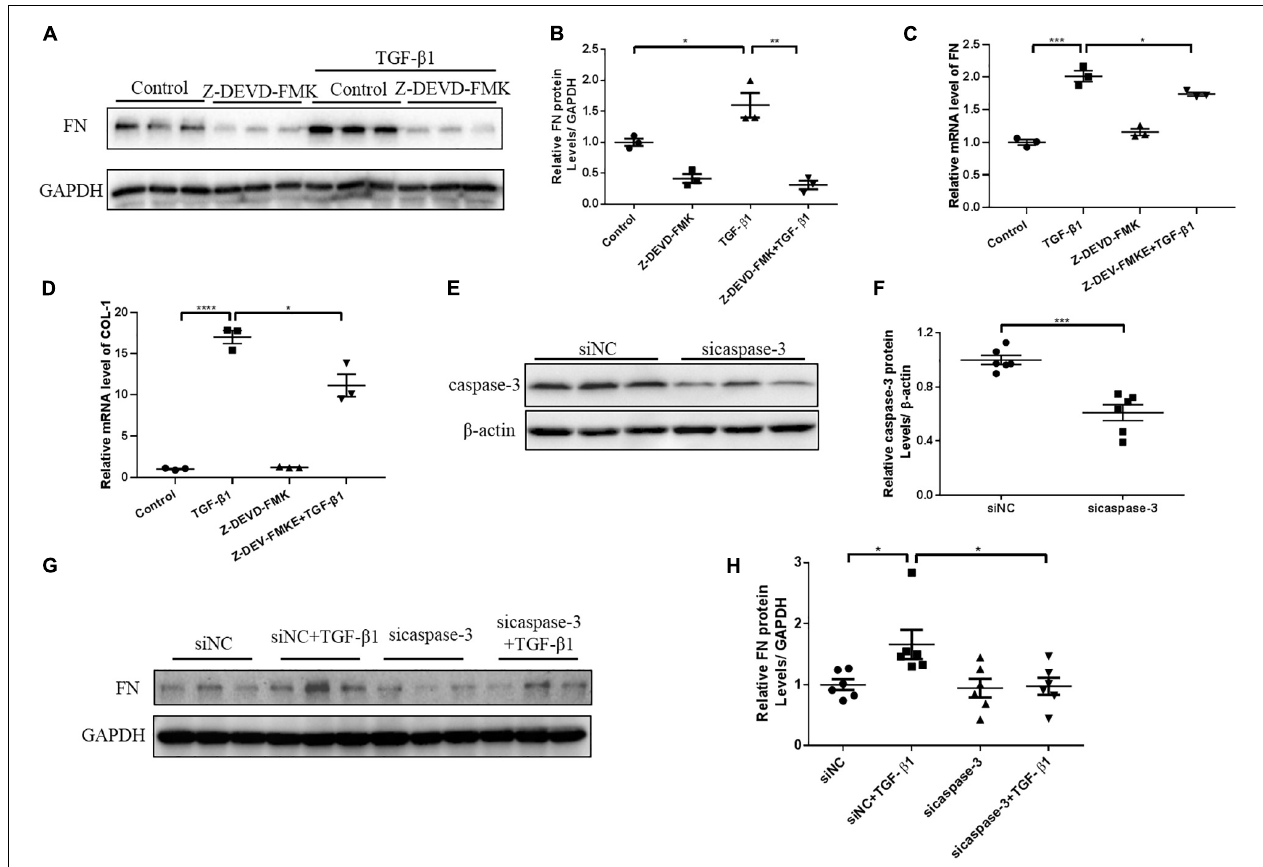
FIGURE 6 | Caspase-3 inhibition alleviates profibrotic response in TGF- β 1-treated renal tubular epithelial cells. HK-2 cells pretreated with Z-DEVD-FMK (100 µ M) and cells treated with caspase-3 siRNA were used to identify the effect of caspase-3 inhibition on renal fibrosis. (A,B) Western blotting analysis of FN in HK-2 cells pretreated with Z-DEVD-FMK. (C,D) qPCR analysis of FN and COL-1 in HK-2 cells pretreated with Z-DEVD-FMK. (E,F) Silencing efficiency of caspase-3 siRNA detected by western blotting analysis. (G,H) Western blotting analysis of FN in cells transfected with caspase-3 siRNA followed by treatment with TGF- β 1 (10 ng/mL). For the cell experiments, three independent experiments were performed. The quantitative results were shown as the means ± SEM. n = 3–6 in each group. * p < 0.05; ** p < 0.01; *** p < 0.001; **** p <